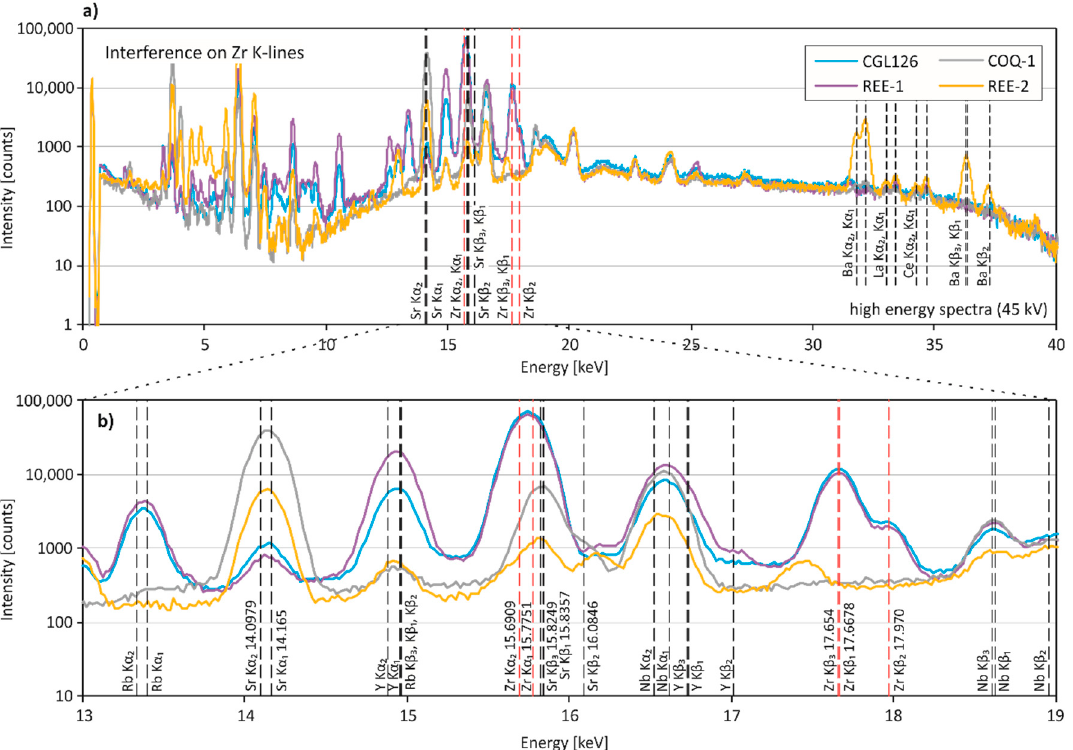
Figure 6. Spectral interferences on Zr. ( a ) The entire energy region (0–40 keV) and ( b ) the close-up of representative X-ray fluorescence spectra for pXRF measurements of CGL126, REE-1, COQ-1, and REE-2. ( b ) Zr K-lines are shown in red, and additional K-lines of interfering elements are in black. Excitation energy of the measurements was 45 kV.